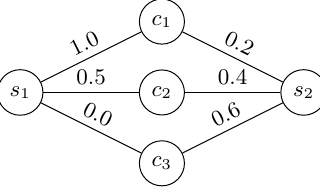
Figure 8. An example of a relevance graph for two groups of stakeholders and three types of